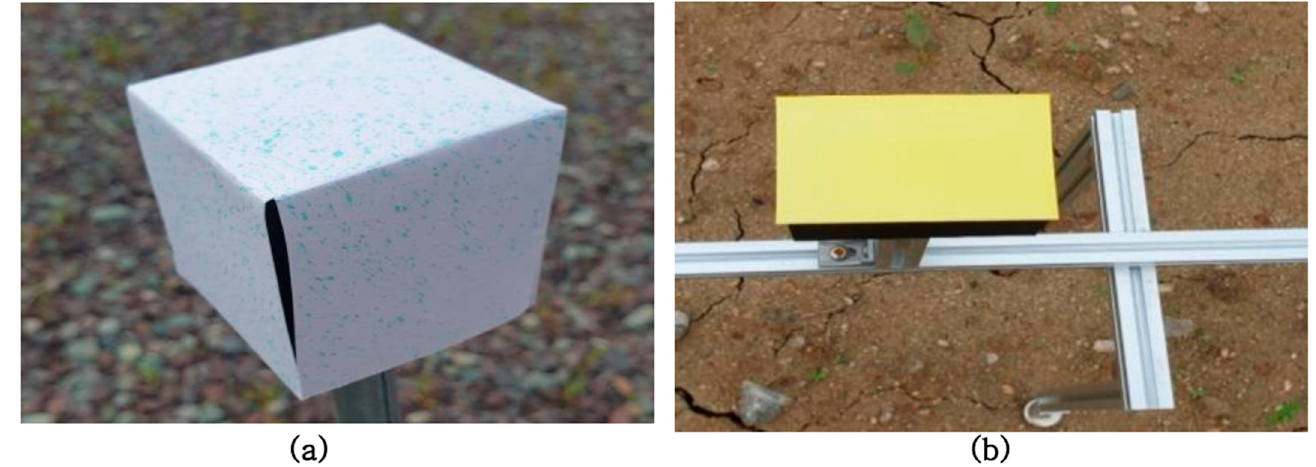
Figure 2. Spray deposition collector ( a ) Medley velvet; ( b )